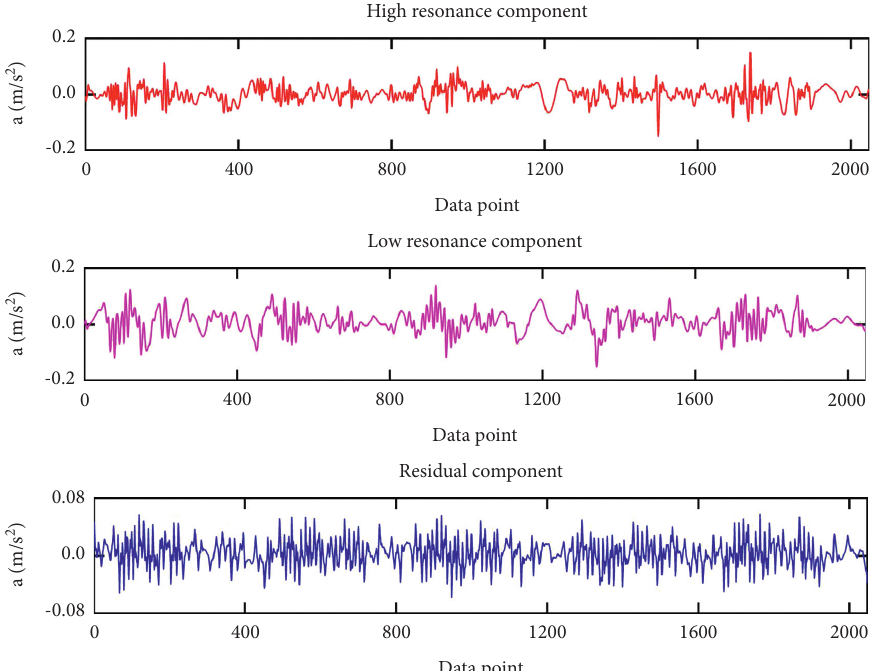
Figure 10: The RSSD decomposition result of vibration signal nor.